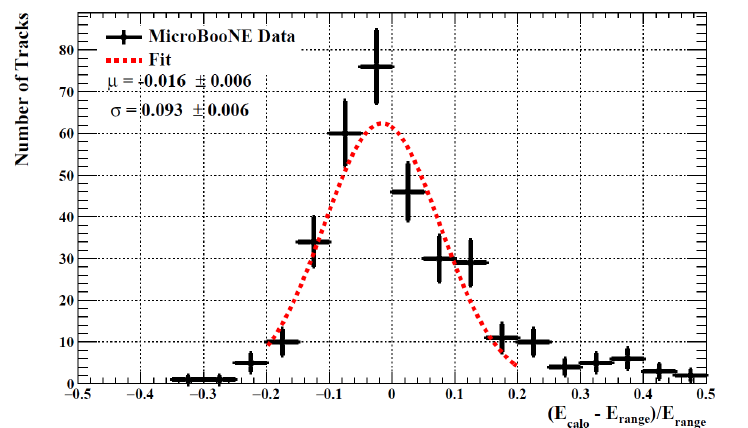
Figure 6. Comparison between the total energy of stopping muons measured by hit-by-hit calorimetry and the energy calculated from the track range. Taken from [21].